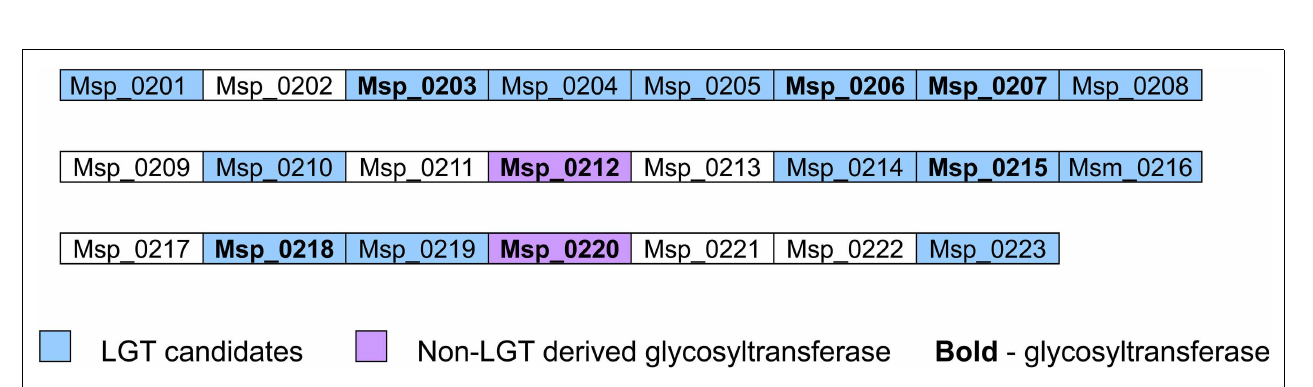
a permease), and both annotated polysaccharide/polyol